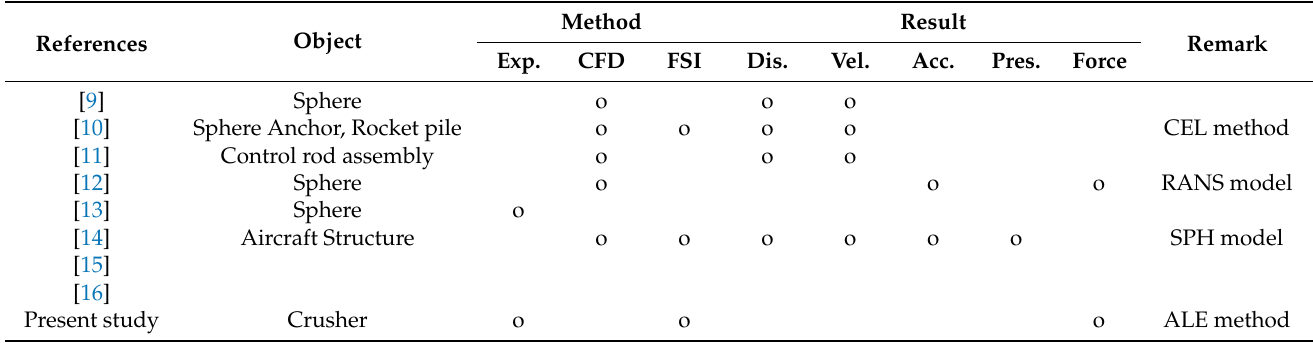
Table 1. Various studies on dropping